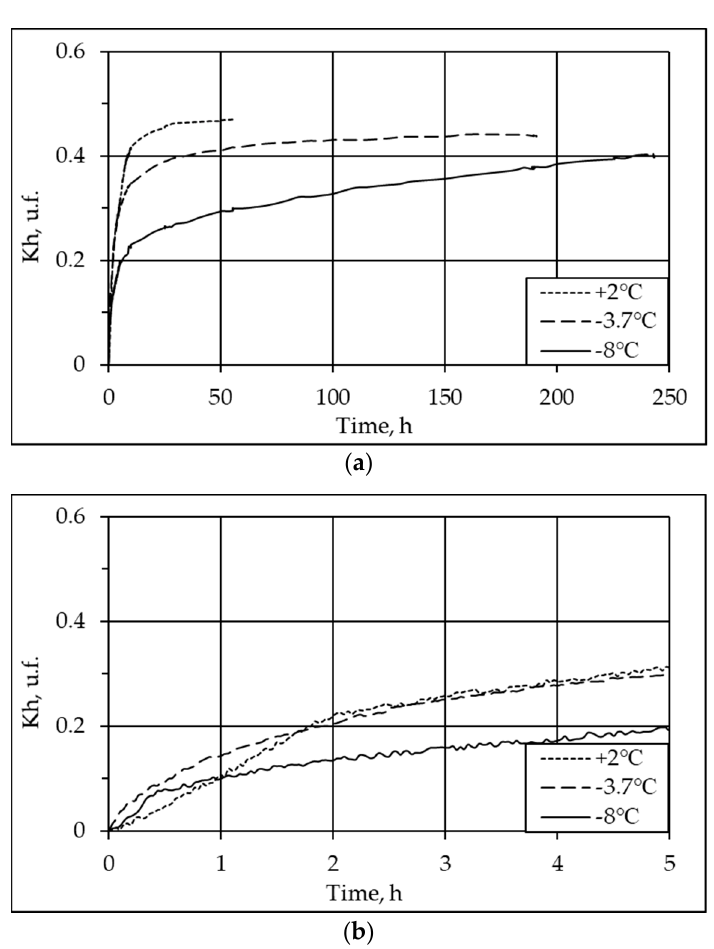
Figure 6. Time-dependent pore methane hydrate formation in sample silt 1 ( W = 14%, Si = 69%) at different temperatures: ( a ) whole run duration; and ( b ) first 5 hours.